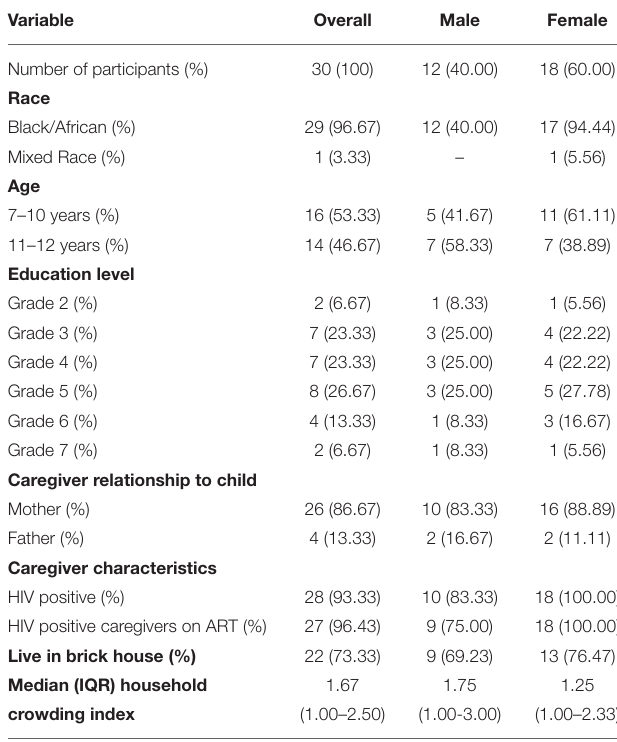
TABLE 2 | Characteristics of children participating in the Disclosure study ( n =